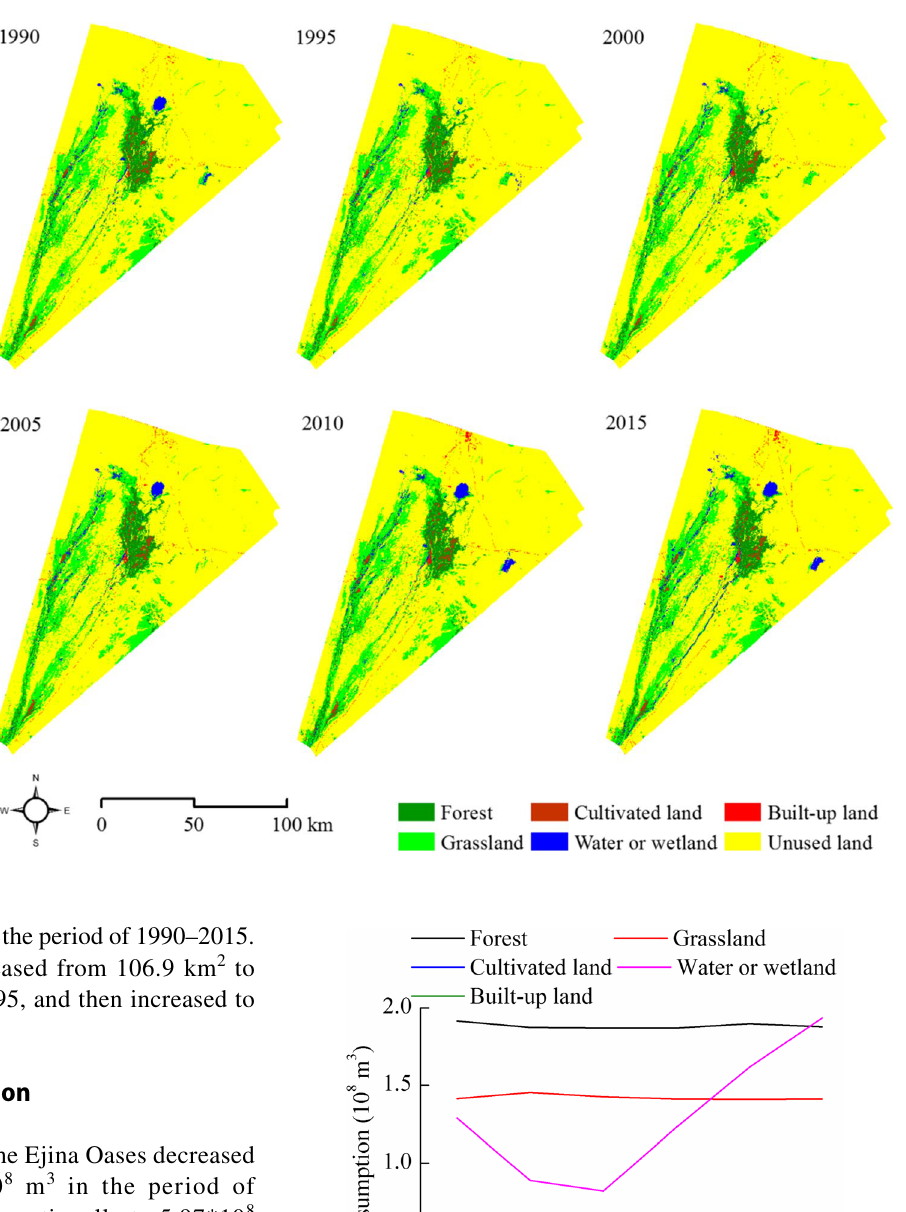
Fig. 2 The land use/cover